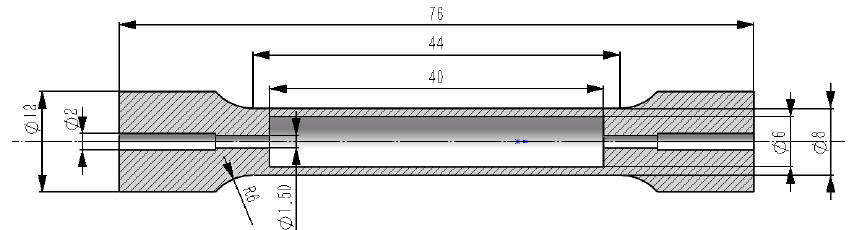
Figure 2. The cross-sectional figure of the tensile test specimen. The corresponding dimensions are marked in mm . The hatched region is the cross-sectional view of the test specimen shell and the blank region in the middle is the filling area after the lattice unit cells array.